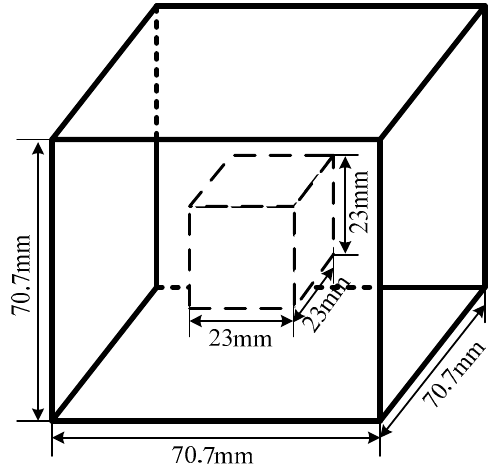
Figure 1. Illustration of cement mortar with a sandwich structure.